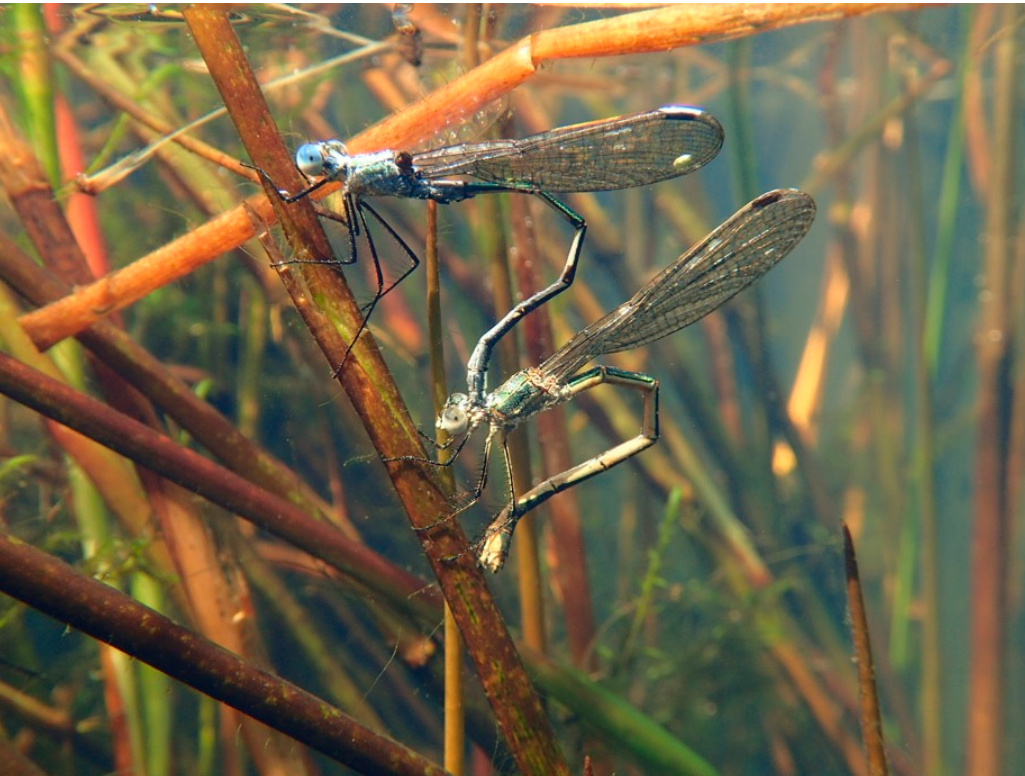
Figure 2. Tandem of Lestes sponsa ovipositing underwater in the net